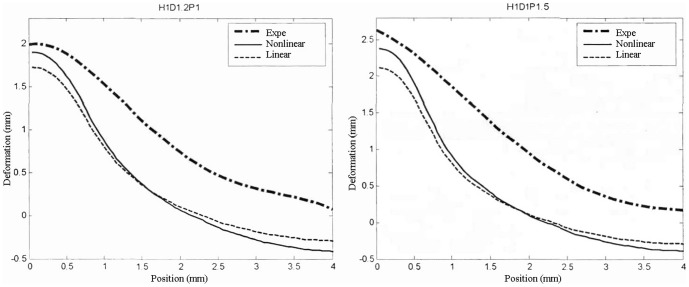
Finger deformation with H1D1.2P1 and H1D1P1.5.